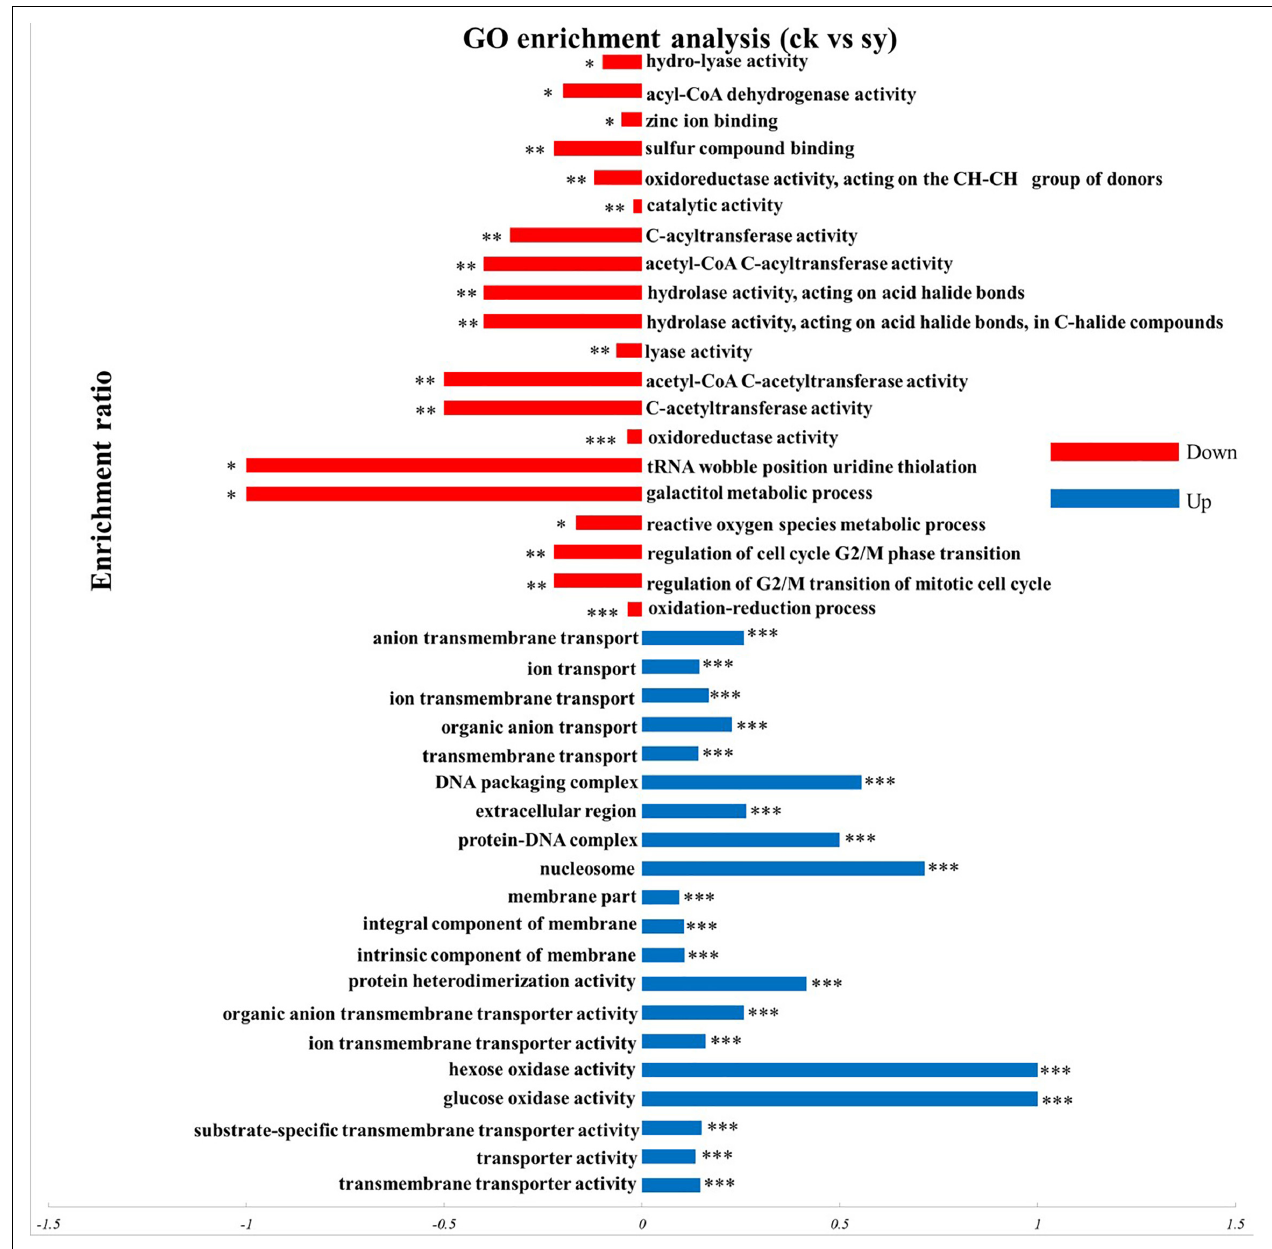
FIGURE 3 | GO enrichment analysis of DEPs in P. digitatum cells. * p < 0.05, ** p < 0.01, *** p < 0.001.